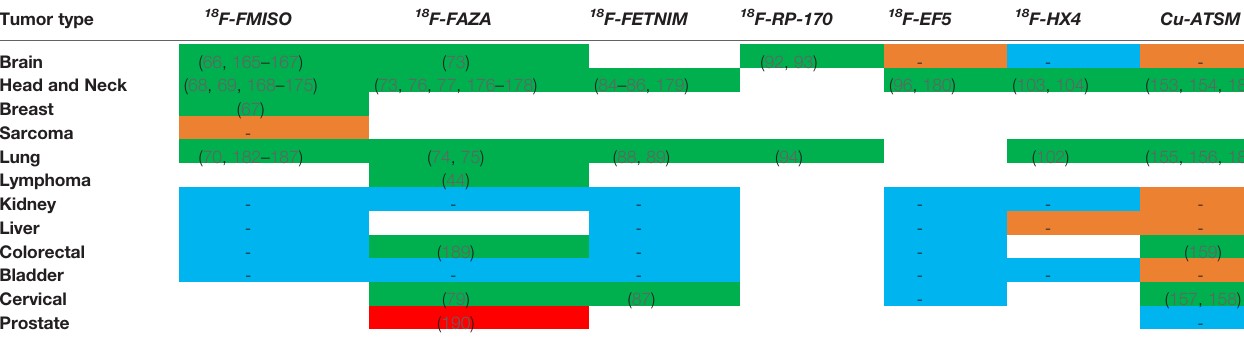
TABLE 3 | Partial summary of clinical imaging studies of hypoxia tracers. Tumor type